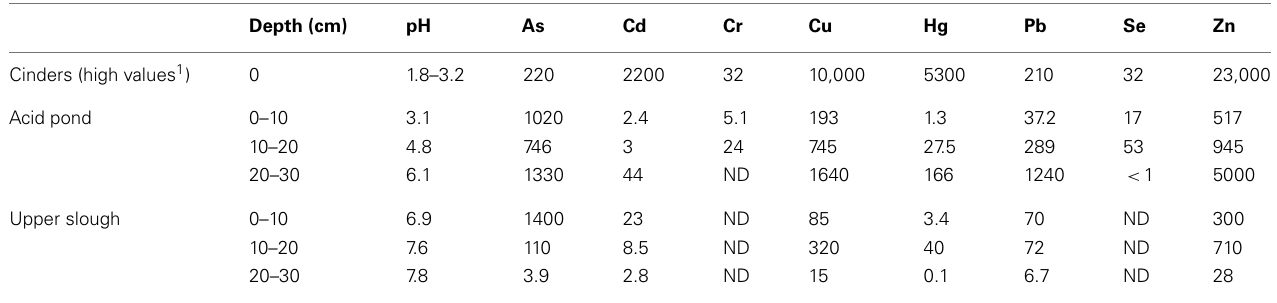
Data were taken from URS Corporation (2002). 1 URS (2000) Field-sampling and analysis results: Stege Marsh, consultancy report. ND, no